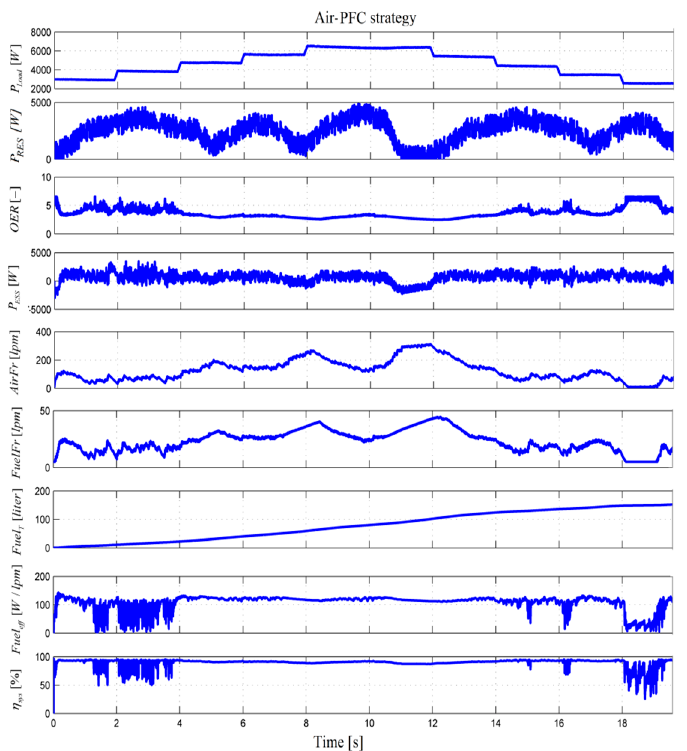
Figure 10. FC/renewable HPS behavior using sFF strategy.